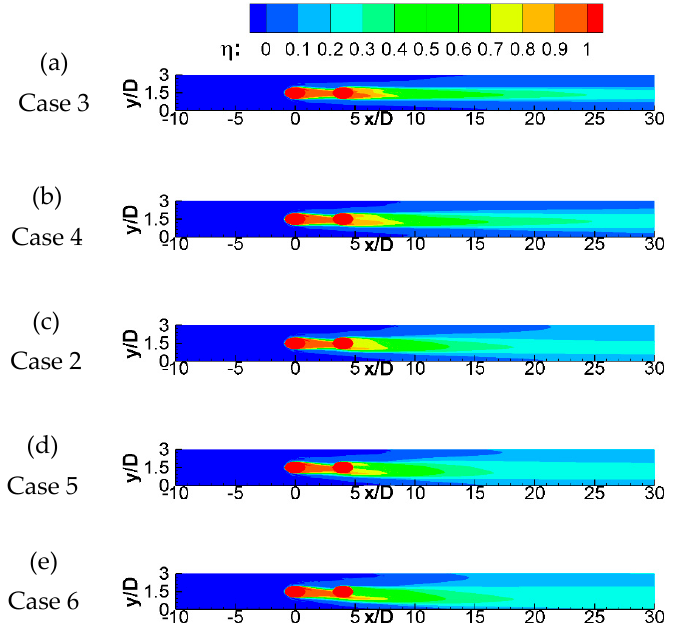
Figure 13. The contours of the time-averaged film cooling effectiveness η on the bottom wall of double rows film cooling with various backward-downstream-jet blowing ratios of ( a ) BR = 0.20, ( b ) BR = 0.35, ( c ) BR = 0.50, ( d ) BR = 0.65, and ( e ) BR = 0.80.